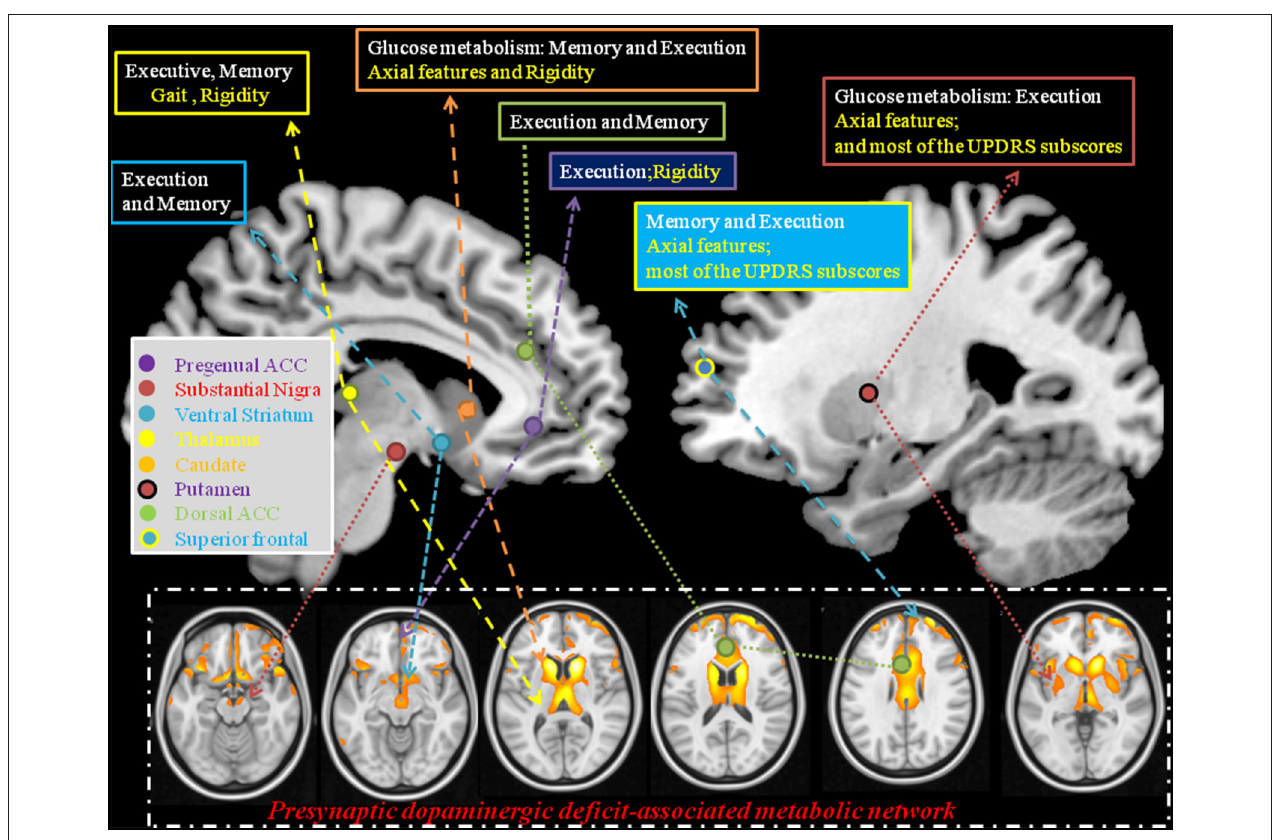
FIGURE 7 | Explanatory model using statistical analysis results from the pre-synaptic deficit-associative metabolic network with symptom segregation. The results highlight the clinical roles of thalamus, caudate, pregenual ACC, superior frontal, and putamen in mediating cognitive and Parkinsonian features. ACC, anterior cingulate cortex; Text in white, cognitive domains; Text in yellow, parkinsonism domains; UPDRS, Unified Parkinson’s Disease Rating